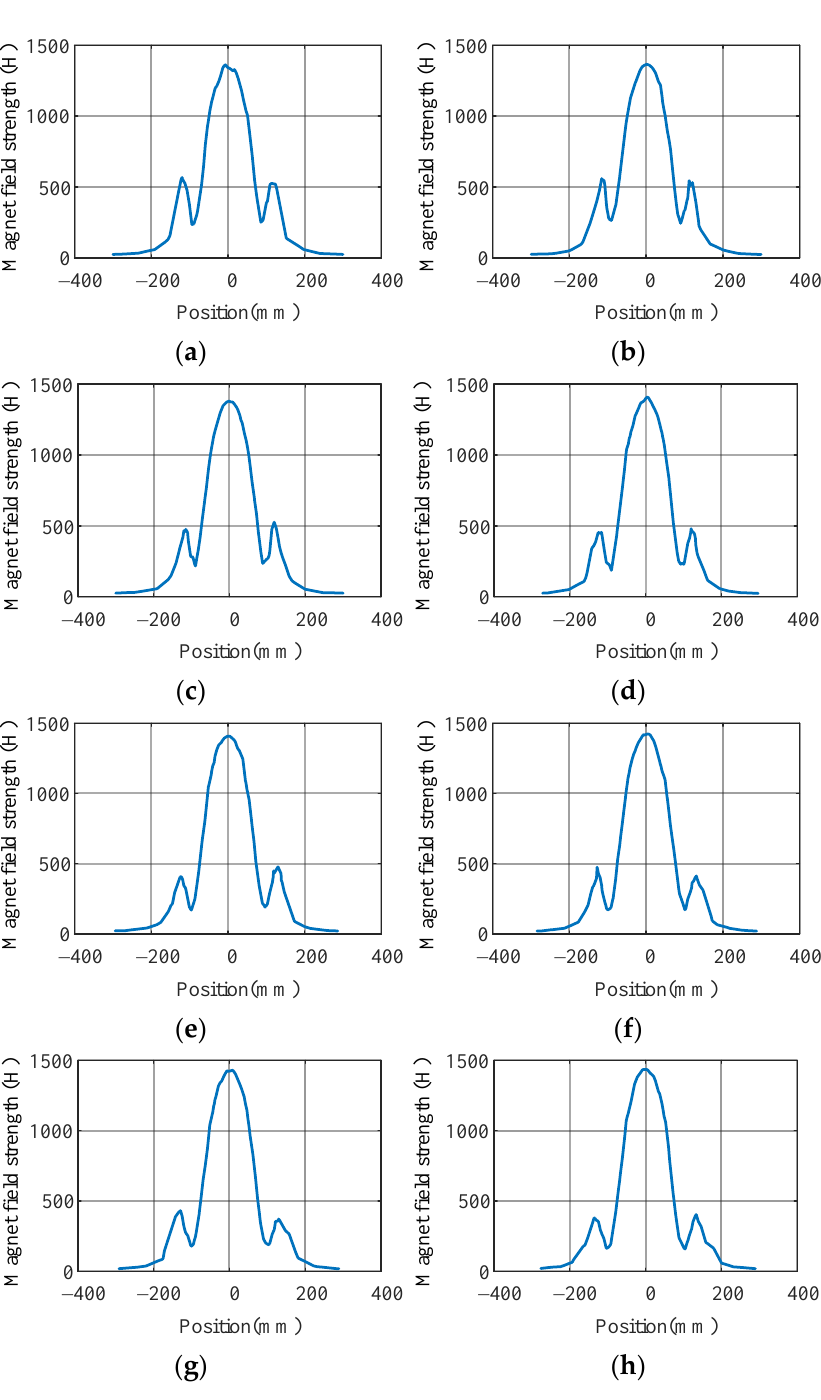
Figure A1. Magnetic field strength curves with different radiuses. ( a ) 112 mm. ( b ) 116 mm. ( c ) 120 mm. ( d ) 124 mm. ( e ) 128 mm. ( f ) 132 mm. ( g ) 136 mm. ( h ) 140 mm. The magnetic field strength curves with different depths, input powers, MnZn ferrite relative permeabilities and NiZn ferrite relative permeabilities are shown in Figures A2–A5, respectively.